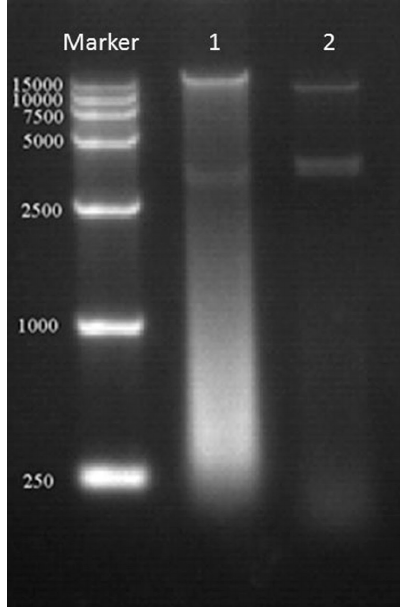
Figure 1. DNA fragmentation was examined with agarose gel electrophoresis. 1 represents the irradiated mites, and 2 represents the normal mites. irradiated mites, and 2 represents the normal